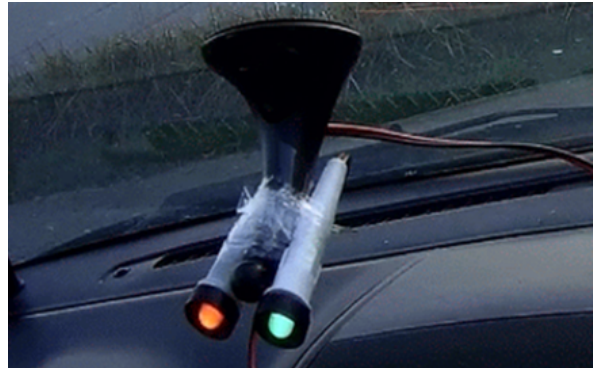
Figure 3: Compound stimulus siren